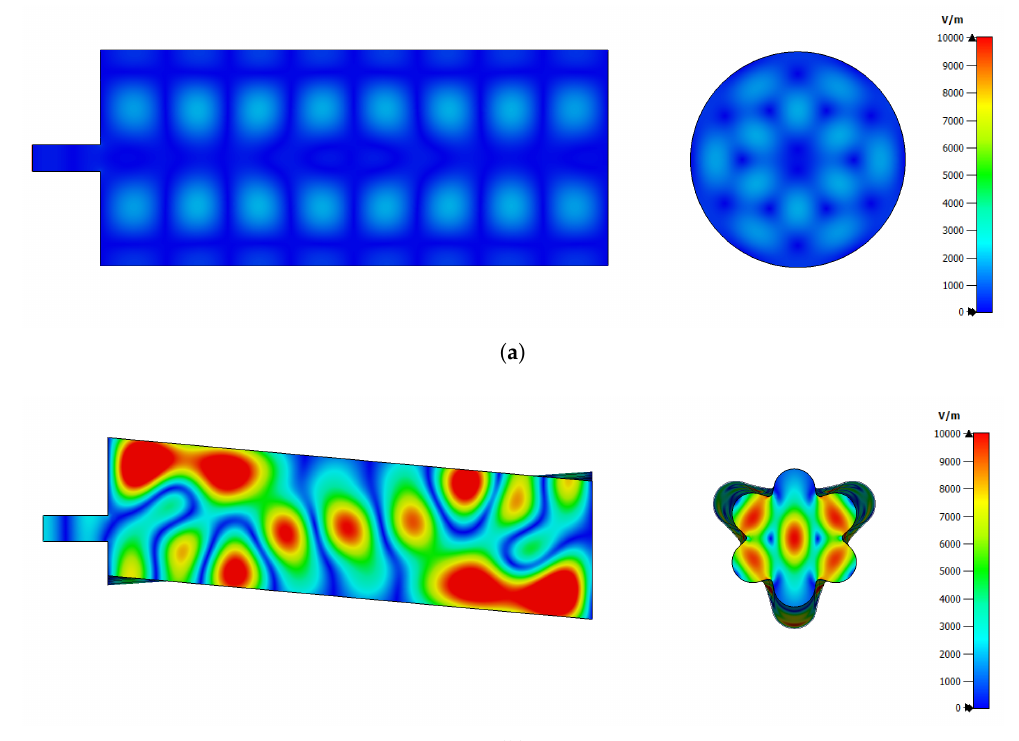
Figure 4. Electric field module plot on side and front slices for: ( a ) cylindrical cavity ( f 0 = 14.457 GHz) and ( b ) “plasma- shaped” cavity ( f 0 = 14.304 GHz). Electric field has been normalized to the maximum value of 10